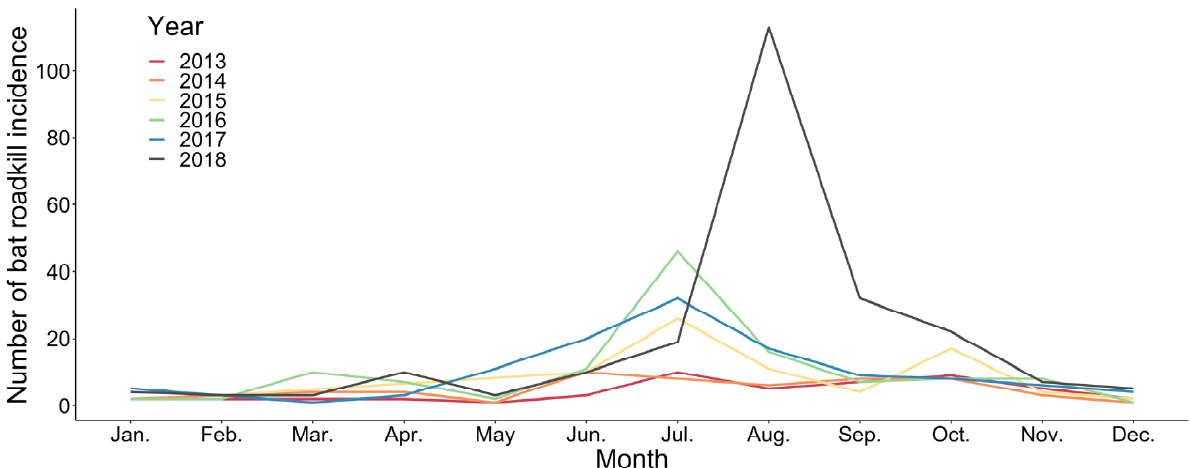
Figure 1. Monthly variations in number of bat roadkills in Taiwan from 2013 to 2018.